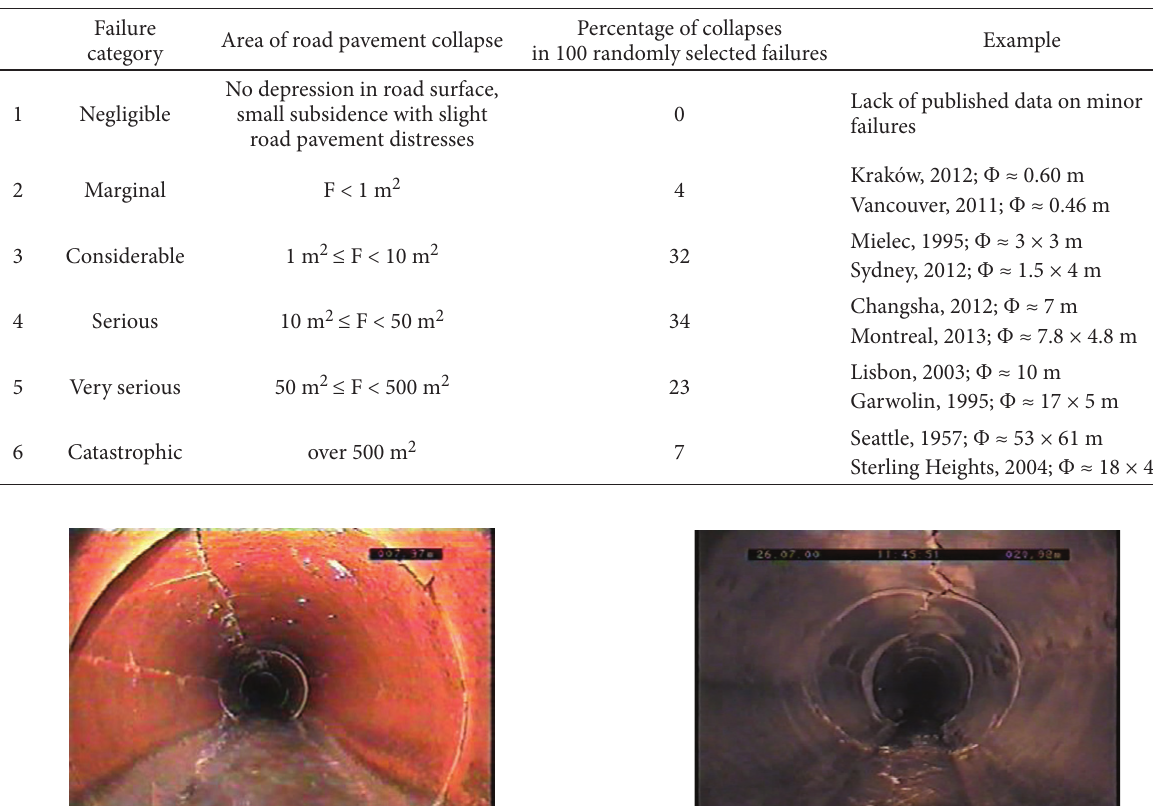
Table 2. Categories of road pavement collapses according to the extent of the road pavement damage